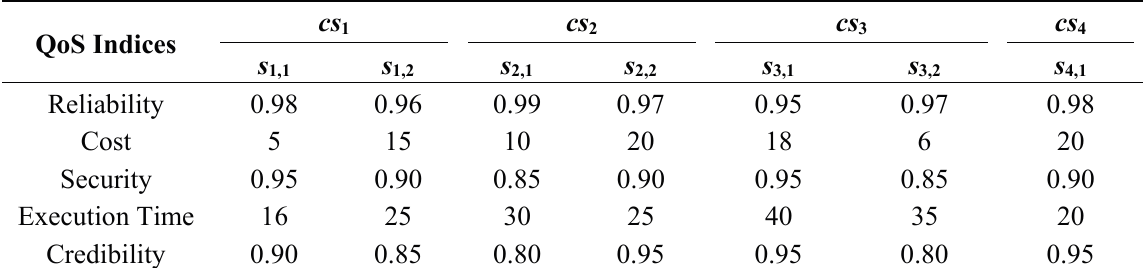
Table 1. The QoS indices values of each service in the numerical